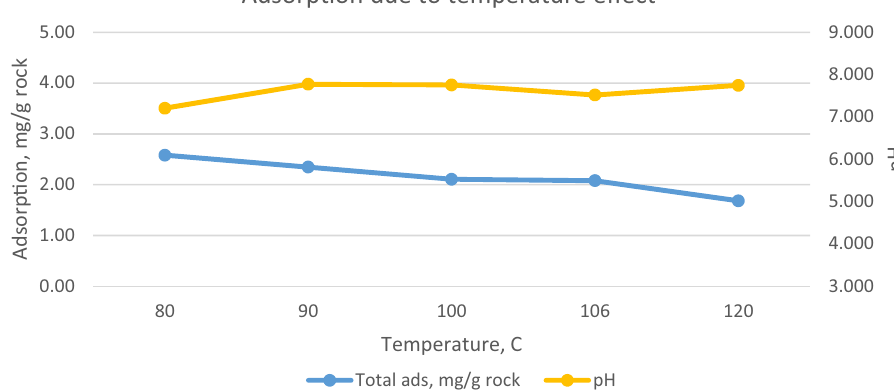
Fig. 15 Adsorption relation- ships due to the temperature